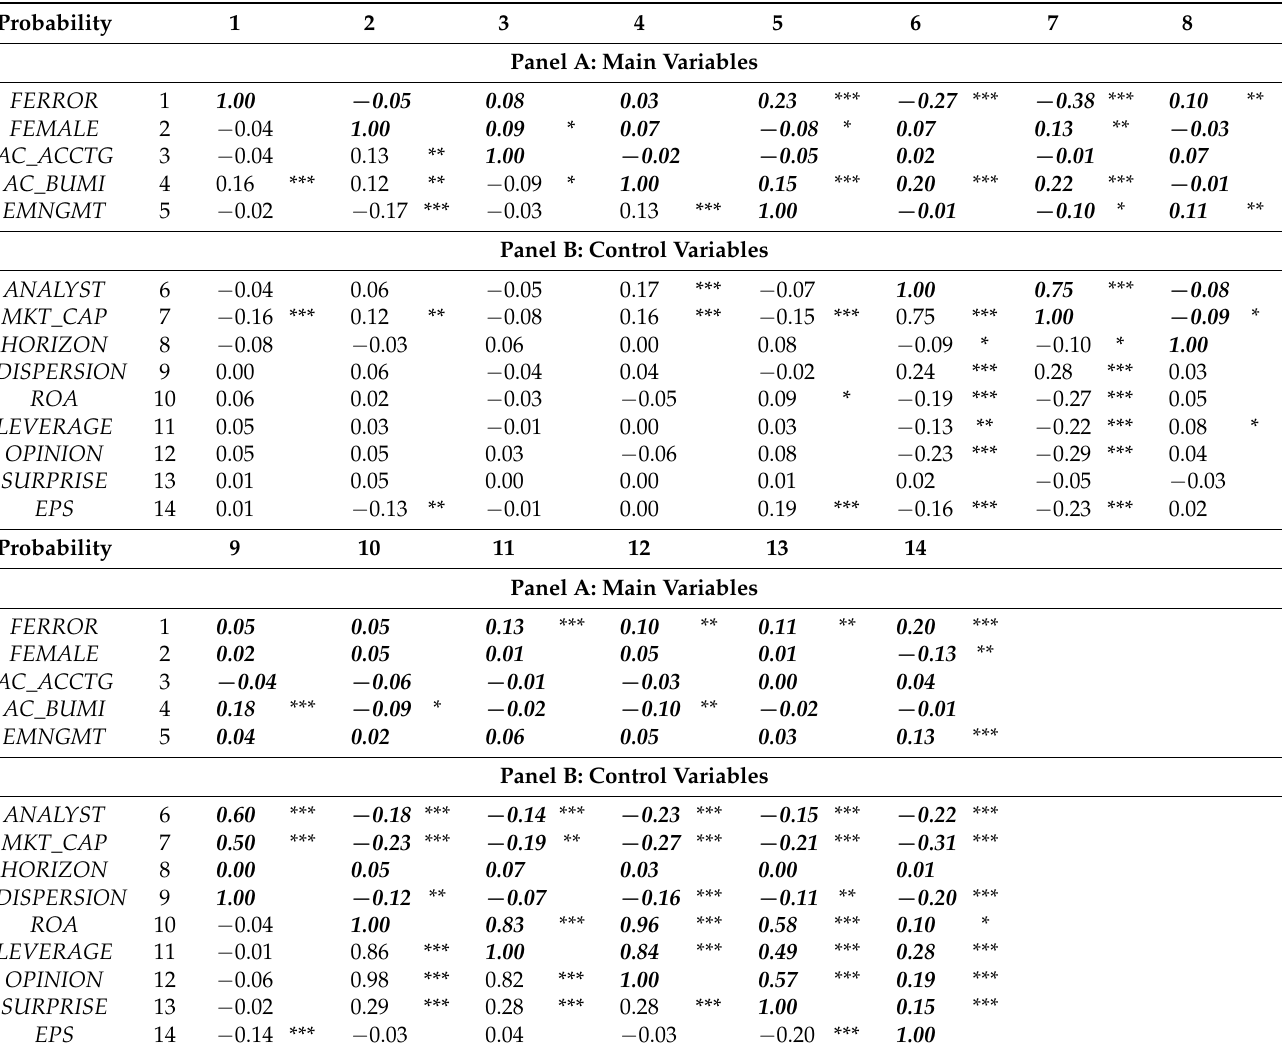
Table 4. Pearson and Spearman Correlation Analysis of the Variables used in the Study. Spearman Correlations are bold and